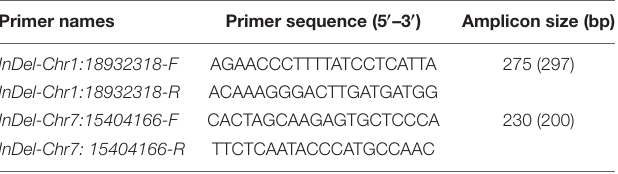
TABLE 5 | Primer information on the two developed markers for qML1.3 and qML7.2. Primer names